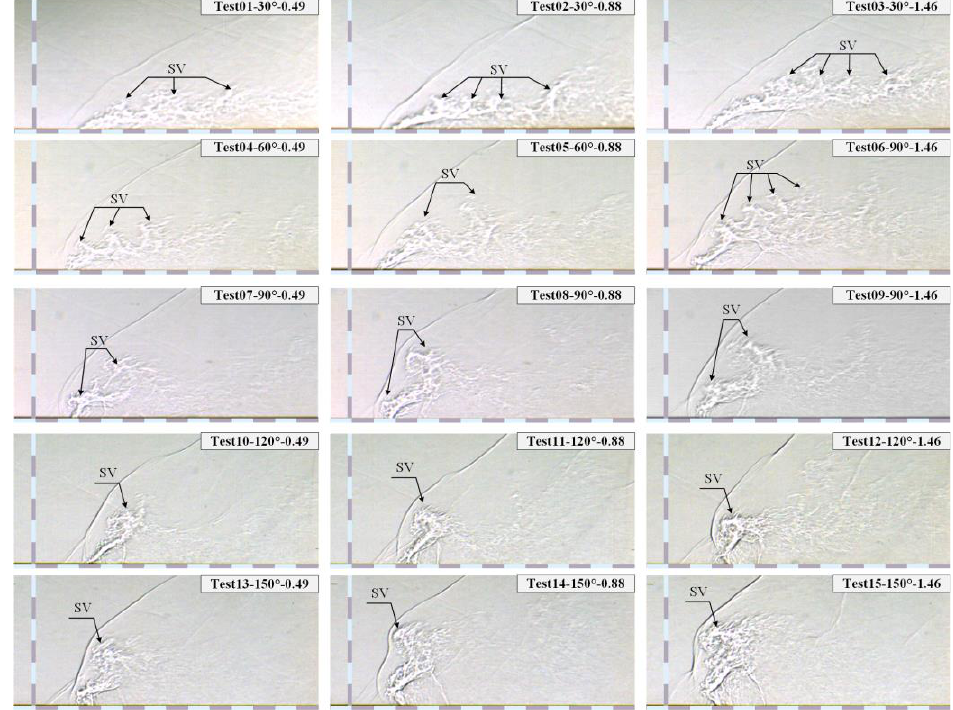
Figure 8. Instantaneous flow field diagrams for different working conditions (see the legends).